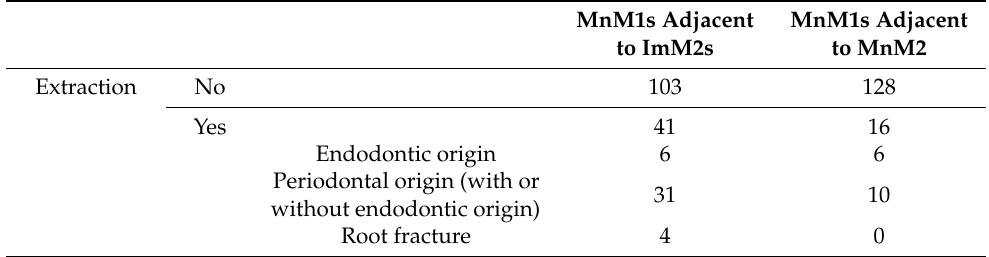
Table 2. The etiology of extraction of the mandibular first molars.